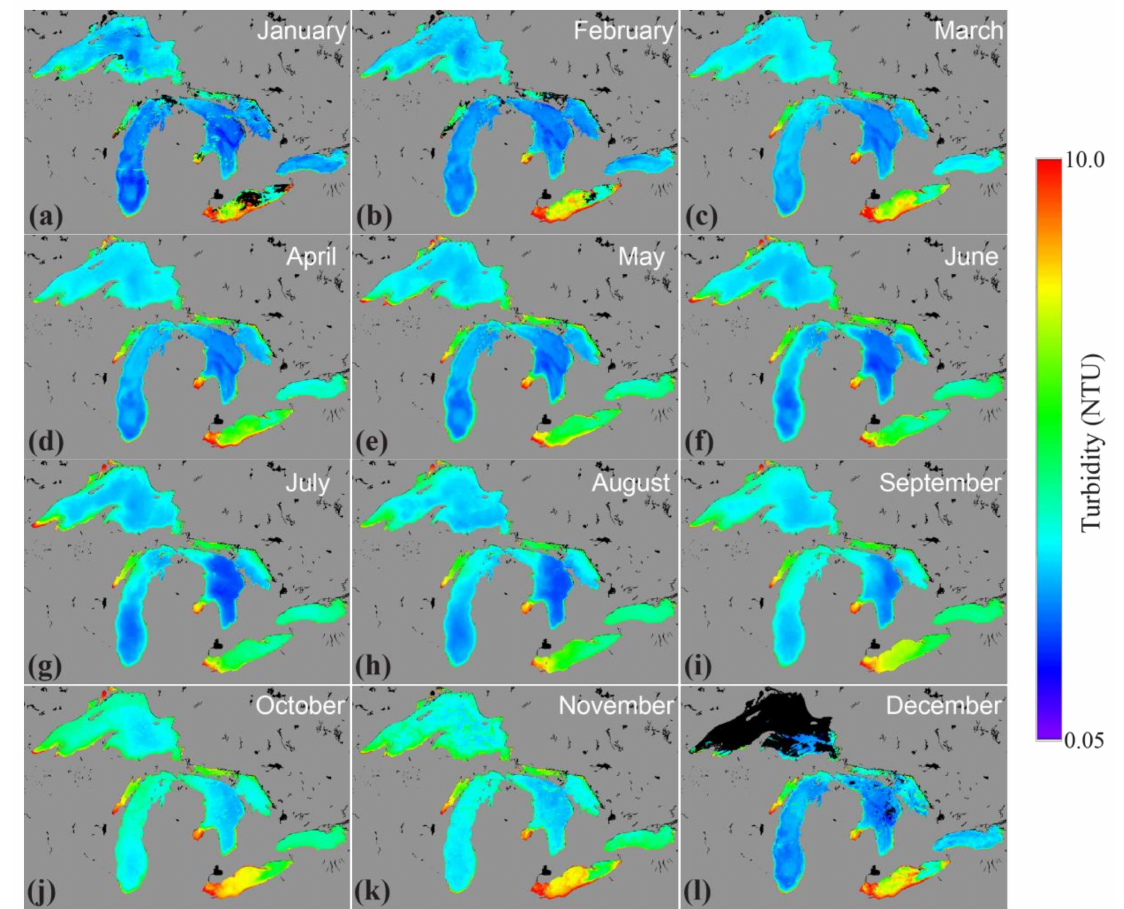
Figure 4. VIIRS–SNPP-measured monthly climatology (2012–2018) turbidity images for the Great Lakes for the months of ( a )–( l ) as